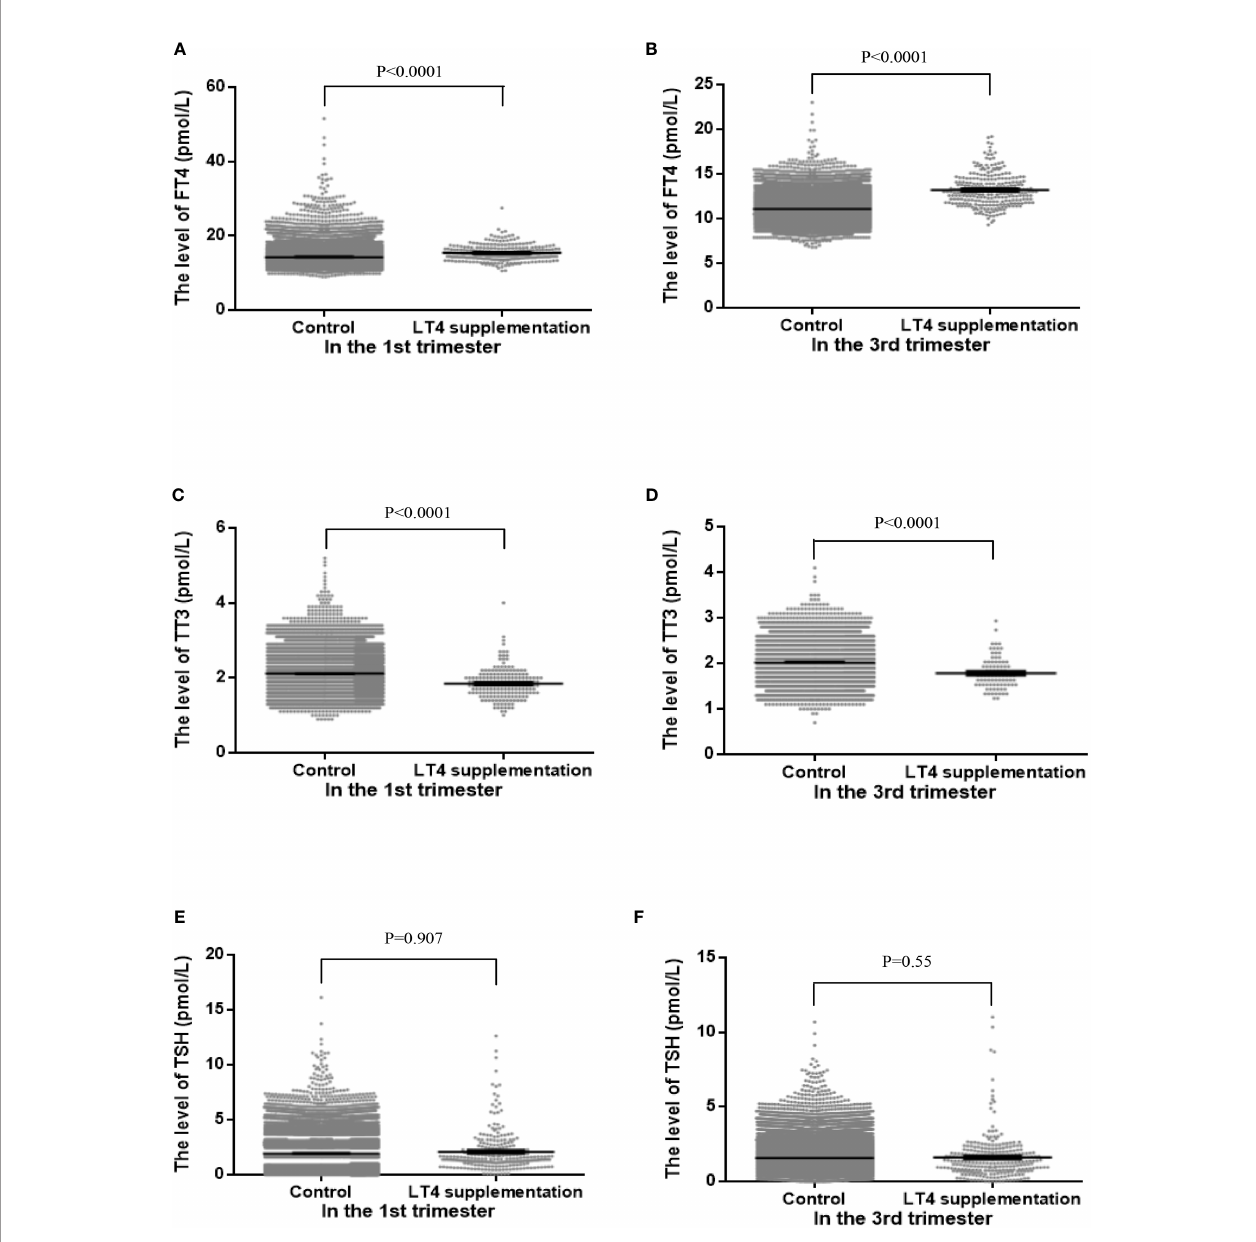
FIGURE 2 | The distributions of maternal free thyroxine (FT4, A , B ), total triiodothyronine (TT3, C , D ) and thyrotropin (TSH, E , F ) levels between control group and LT4 supplementation group in the fi rst trimester (left panels) and third trimester (right